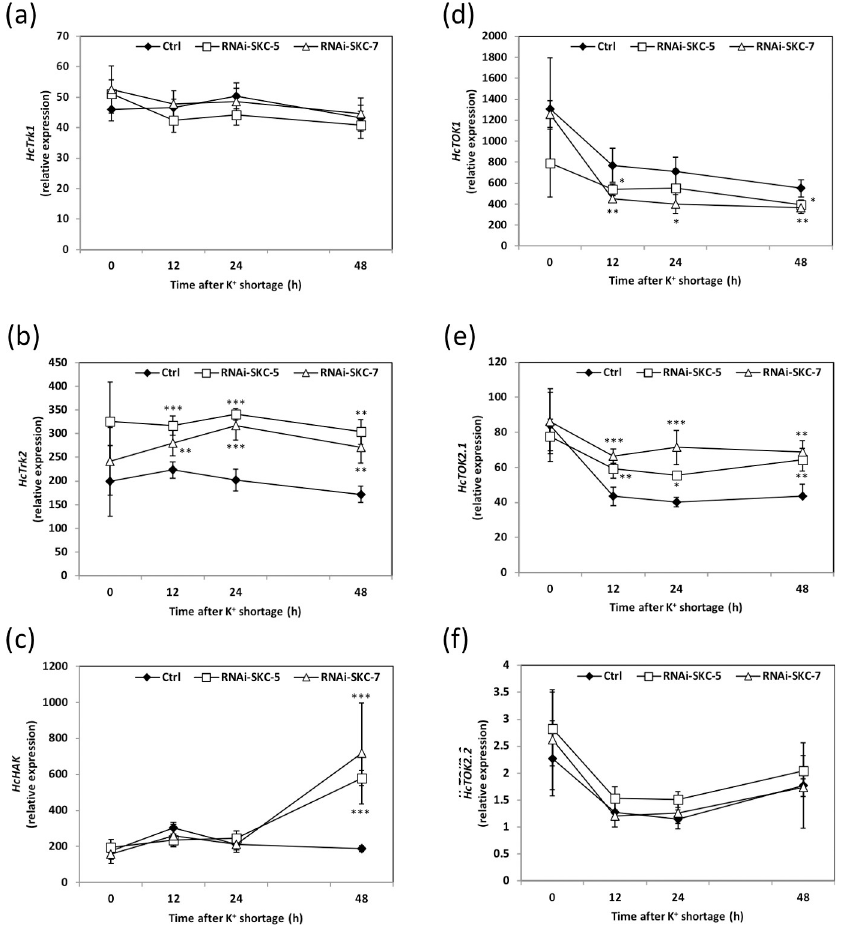
Fig 5. Relative expression of putative K + channels and transporters in Hebeloma cylindrosporum control and HcSKC -silencing lines. Relative expressions of the K + transporters HcTrk1 (a), HcTrk2 (b), HcHAK (c) and the K + channels HcTOK1 (d), HcTOK2 . 1 (e) and HcTOK2 . 2 (f) were analyzed in dependence on K + shortage in control and RNAi fungal lines. The relative expressions of the K + transporter HcTrk2 (b) and the K + channels HcTOK1 (d) and HcTOK2 . 1 (e) were altered in RNAi-SKC-5 and RNAi-SKC-7 lines in comparison to the transgenic control line (Ctrl) under K + limiting conditions. The relative expressions of HcTrk1 (a) and HcHAK (c) K + transporters, and of the K + channel HcTOK2 . 2 (f) were not affected by K + shortage in RNAi-SKC-5 and RNAi-SKC-7 lines in comparison to the transgenic control line (Ctrl). Mean values are provided with the standard error (n = 6). Statistical differences were determined using a one-way ANOVA followed by Dunnett’s test relative to Ctrl strain for each data point P < 0.05 ( � ), P < 0.01 ( �� ) and P < 0.001 ( ��� ).